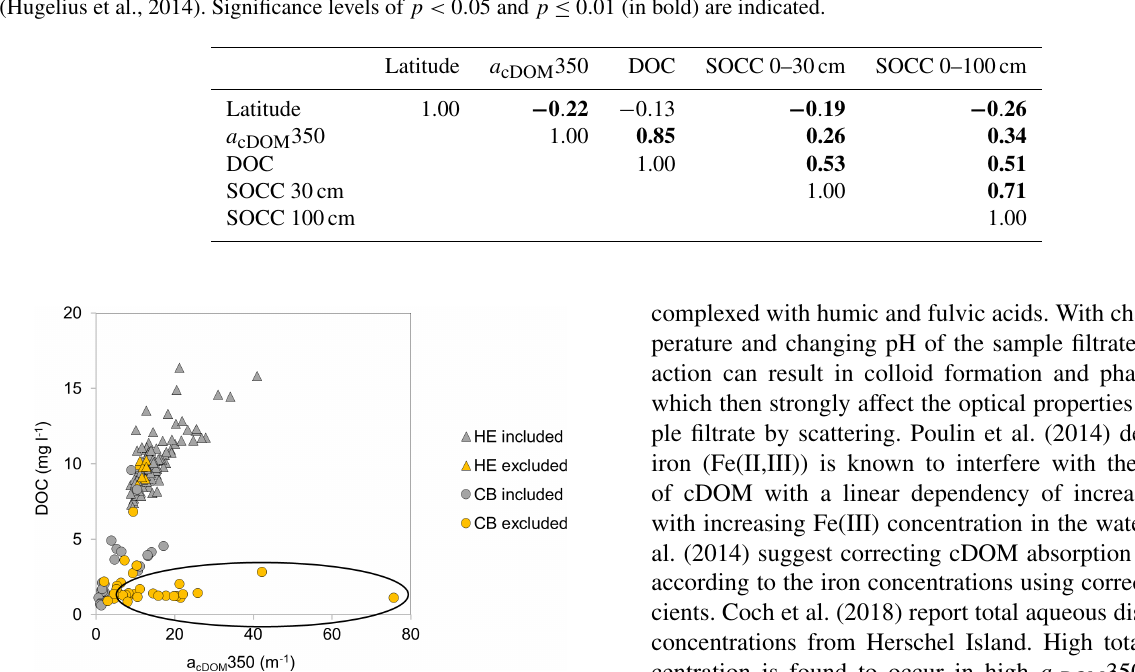
Table 3. Correlation matrix using the Spearman’s ρ correlation coefficient between latitude, dissolved organic carbon concentration (DOC), coloured dissolved organic carbon absorption at 350nm ( a cDOM 350), soil organic carbon content (SOCC) in 0–30 and 0–100cm depth (Hugelius et al., 2014). Significance levels of p < 0 . 05 and p ≤ 0 . 01 (in bold) are indicated.